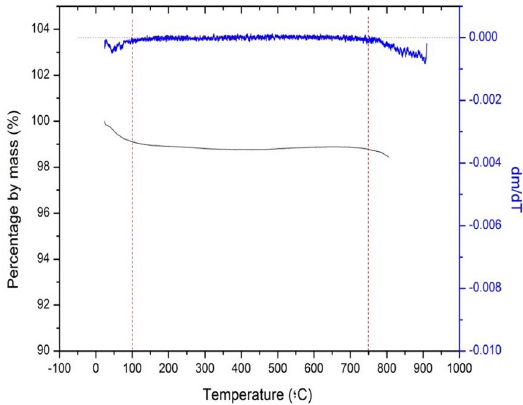
Figure 5. Results of the consistency of the reference mortar and the mortar with 5%, 10%, 15%, 20% and 30% of residual in partial replacement of the cement.